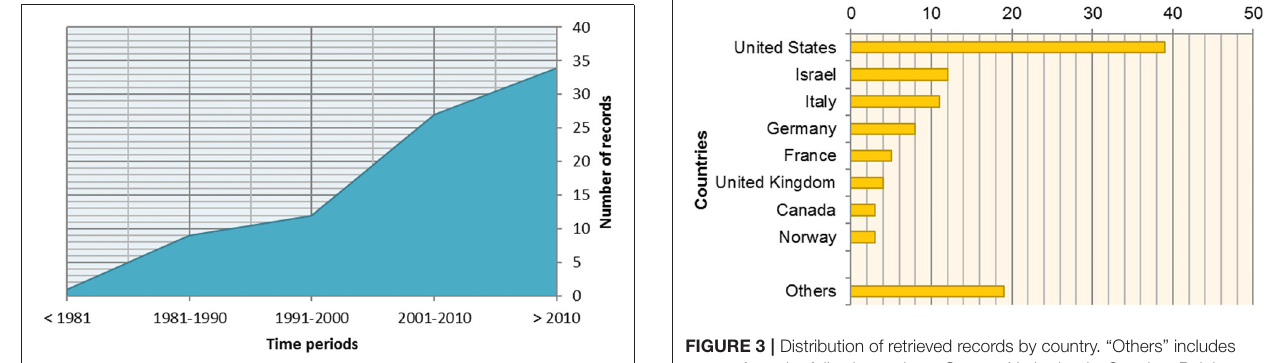
FIGURE 2 | Number of retrieved records clustered in decades.